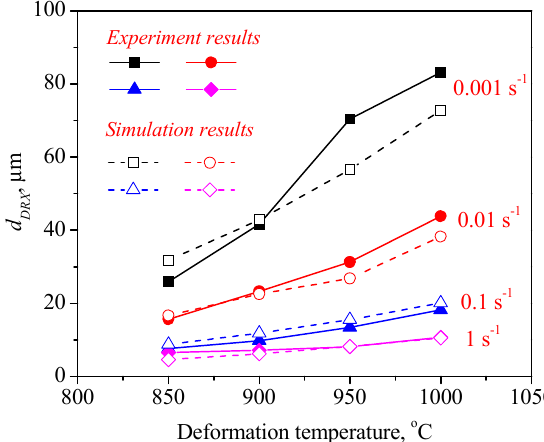
Figure 17. A comparison between the experimental and simulation results for the d DRX .